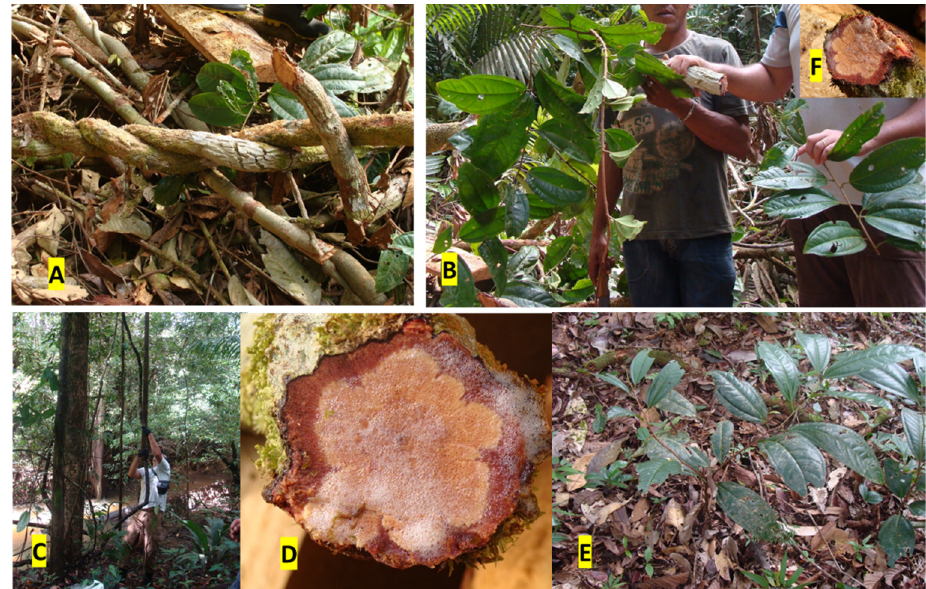
Figure 1. Ampelozyziphus amazonicus . ( A ) Characteristic robust woody liana with twisted stem; ( B ) plant collection showing details of the alternate opposite simple leaves on young stems; ( C ) habitat and habit of A. amazonicus in the forest; ( D , F ) transversal cut of the liana showing the brownish red ritidome with whitish sapwood that produces abundant foaming (saponin rich) upon cutting; ( E ) seedlings of A. amazonicus in a terra firme area. Photos by S.G. Leitão, taken at Ilha do Macaco, along the Erepecuru River, Brazil.